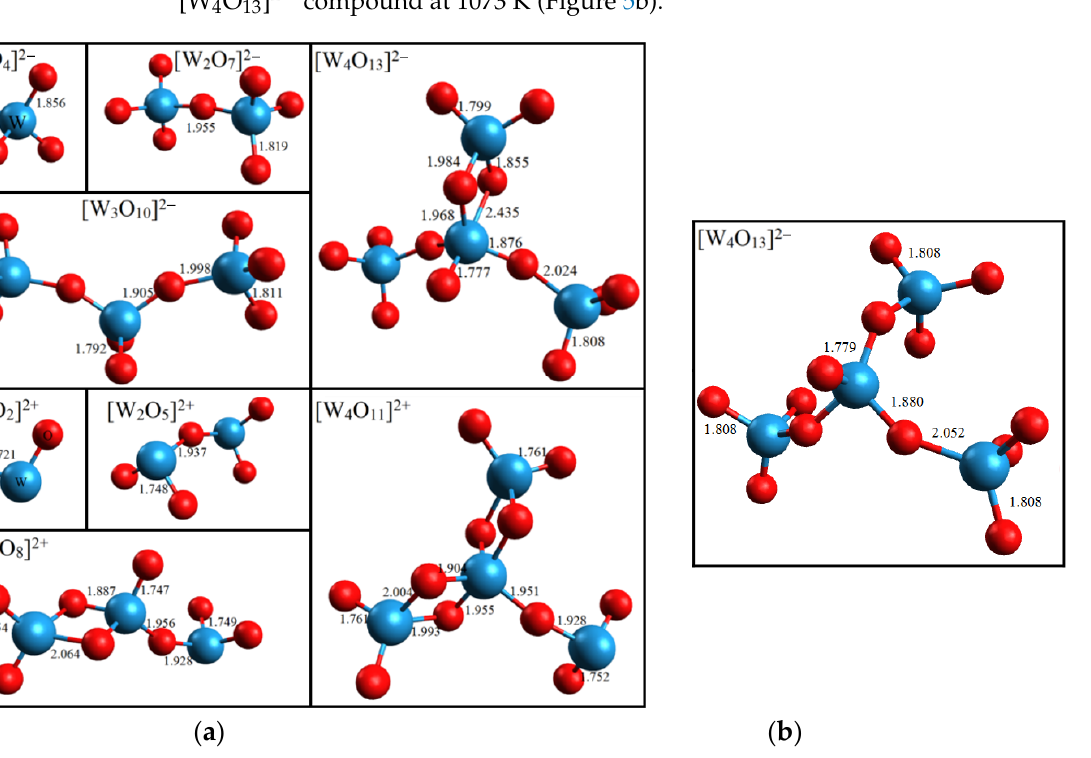
Figure 5. ( a ) Geometric structures of W x O 2 − tion and ab initio molecular dynamics with a Nose–Hoover thermostat at 983 K. ( b ) Geometric structure of [W 4 O 13 ] 2 − at 1073 K. Bond lengths are given in angstroms.